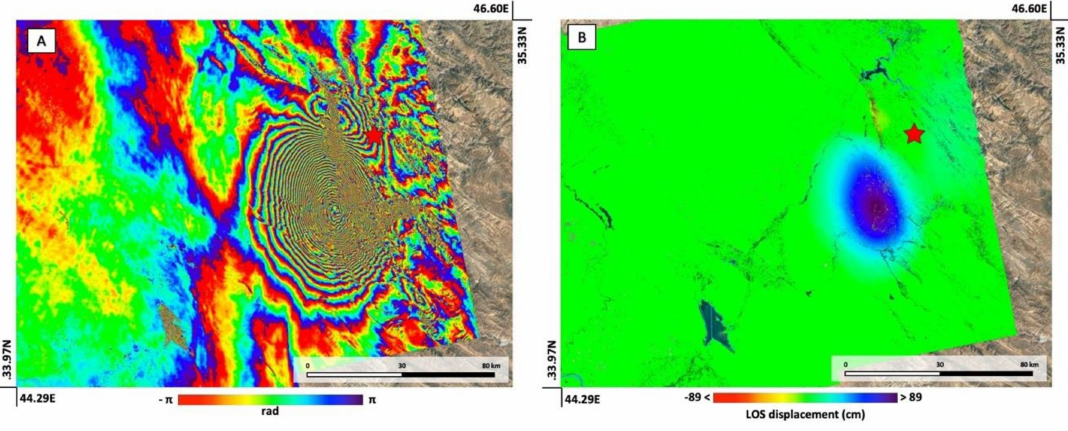
Figure 10. Sentinel-1 results relevant to the 12 November 2017 Halabjah earthquake (Iraq). ( A ) Coseismic interferogram produced from S1 ascending images (Track 72) spanning the time interval 11 November 2017–17 November 2017. ( B ) Coseismic displacement map related to the interferogram reported in ( A ). The red star identifies the epicenter for the seismic